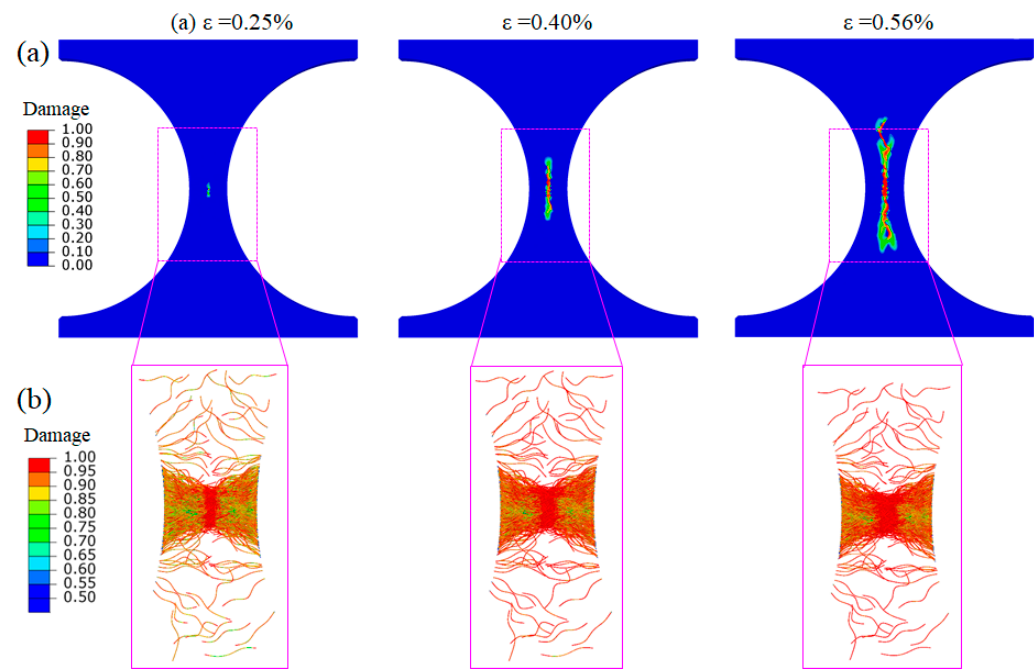
Figure 7. Damage development in the hierarchical FRC with an optimal CNT network with a content of 0.5 wt% at different applied strains. Contour plots of the damage variable in ( a ) the matrix and ( b ) at CNT/matrix interface.